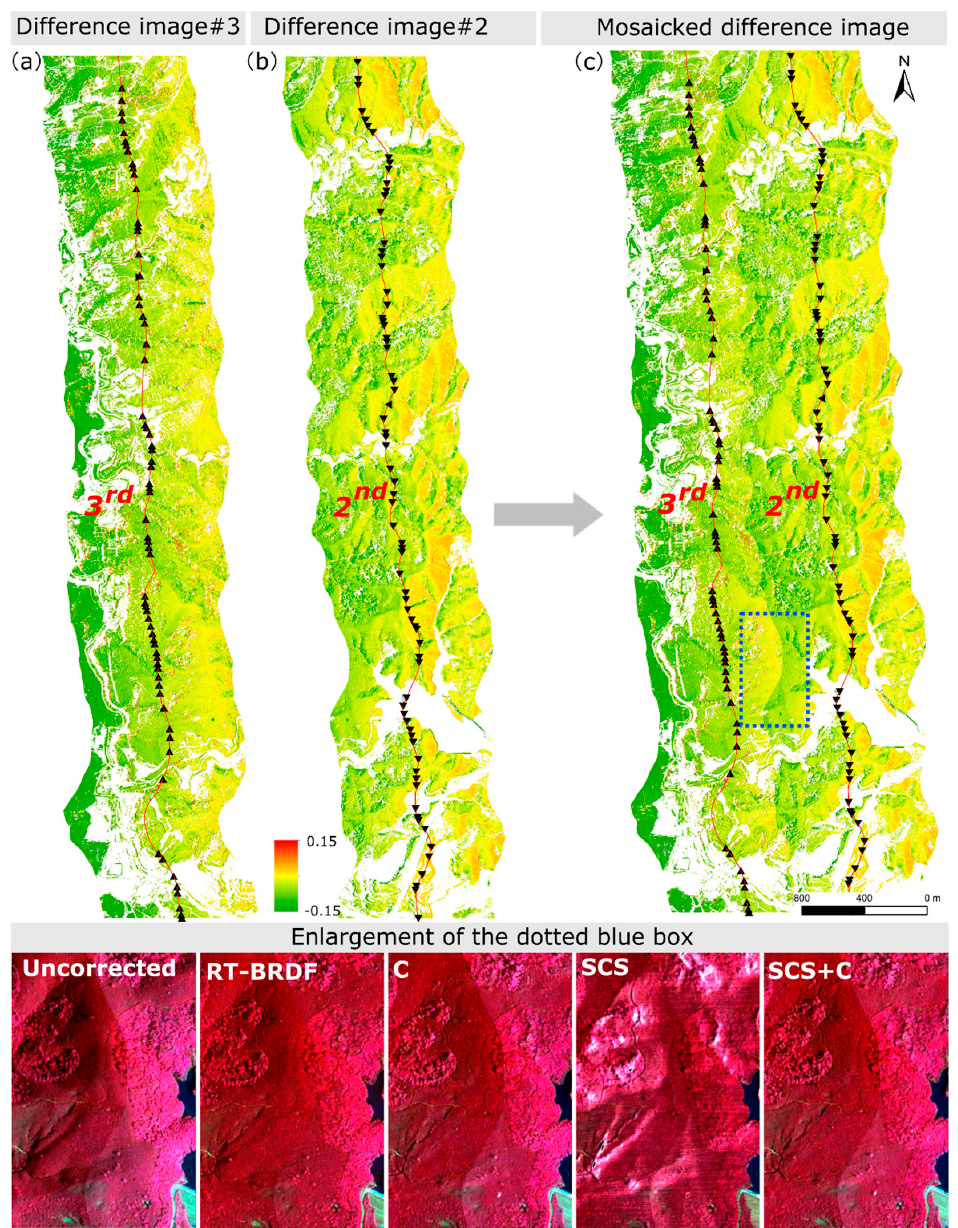
Figure 10. Reflectance difference between RT-BRDF and C correction methods at 837.19 nm for ( a ) the third and ( b ) the second flight-lines (red line, with black arrows showing flight direction); ( c ) difference of mosaicked second and third flight-line and example close up (dotted blue box). Non-forested areas are in white. At the bottom, false-color composite close ups of the region delineated by the dotted blue box are shown.